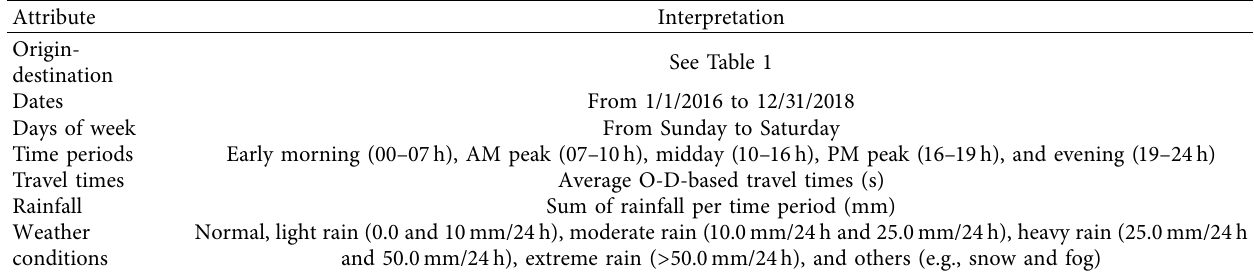
Table 3: Summary of data attributions and